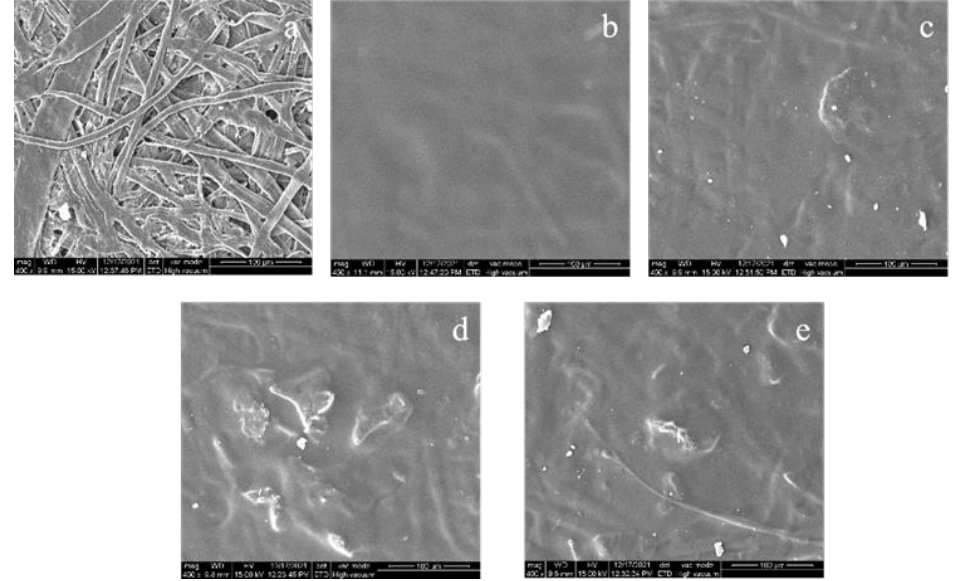
B. subtilis Figure 7. Antibacterial effect of CFEO-M on E. coli, S. aureus and B. subtilis . 3.2. Characterization of Coated Paper 3.2.1. Surface Morphology The effect of coating on paper morphology was observed using ESEM. Figure 8 shows ESEM images of uncoated paper and the four coated papers (P 0 , P 1% , P 2% and P 3% ).